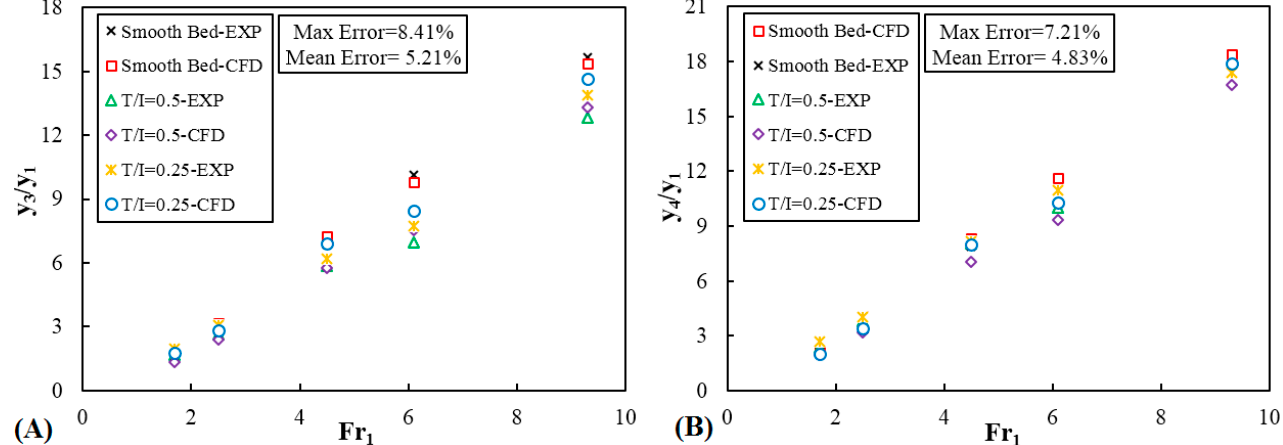
Figure 7. Numerical versus experimental basic parameters of the submerged hydraulic jump. ( A ): y 3 /y 1 ; and ( B ): y 4 /y 1 .